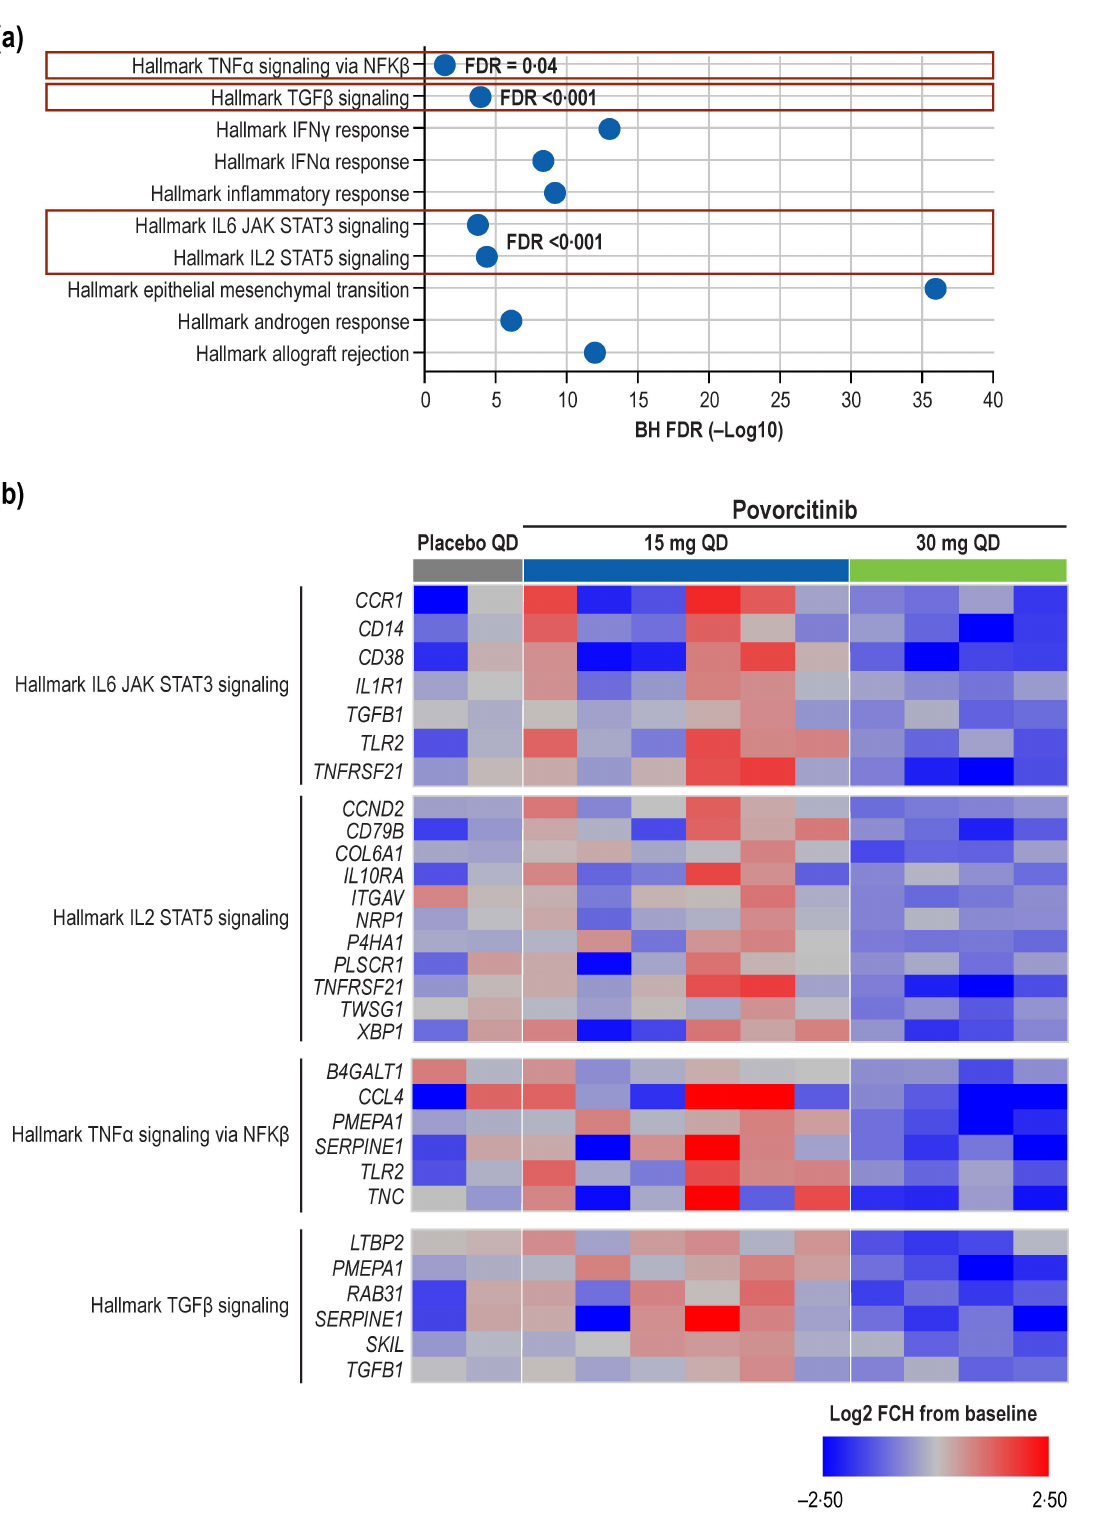
Figure 2. Pathway enrichment analysis. ( a ) Pathway enrichment analysis at Week 8 of treatment with 30 mg povorcitinib QD and ( b ) heatmap of Week 8 DEGs from selected Hallmark signaling pathways. DEG, differentially expressed gene; FCH, fold change; FDR, false discovery rate; QD, once daily. Log2 FCH from baseline is used. HALLMARK signaling pathways were from the Molecular Signatures Database (MSigDB v7 · 2